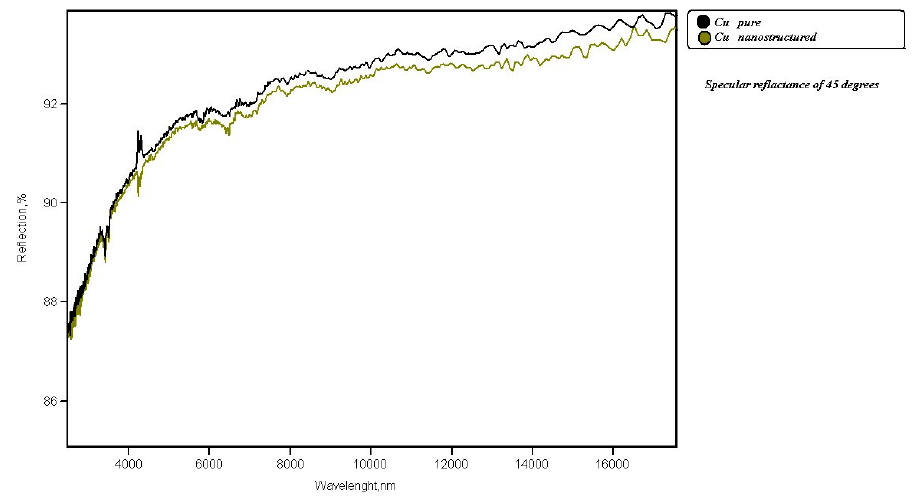
Figure 2. Reflectance spectra of the CNTs-deposited surface and the original copper.